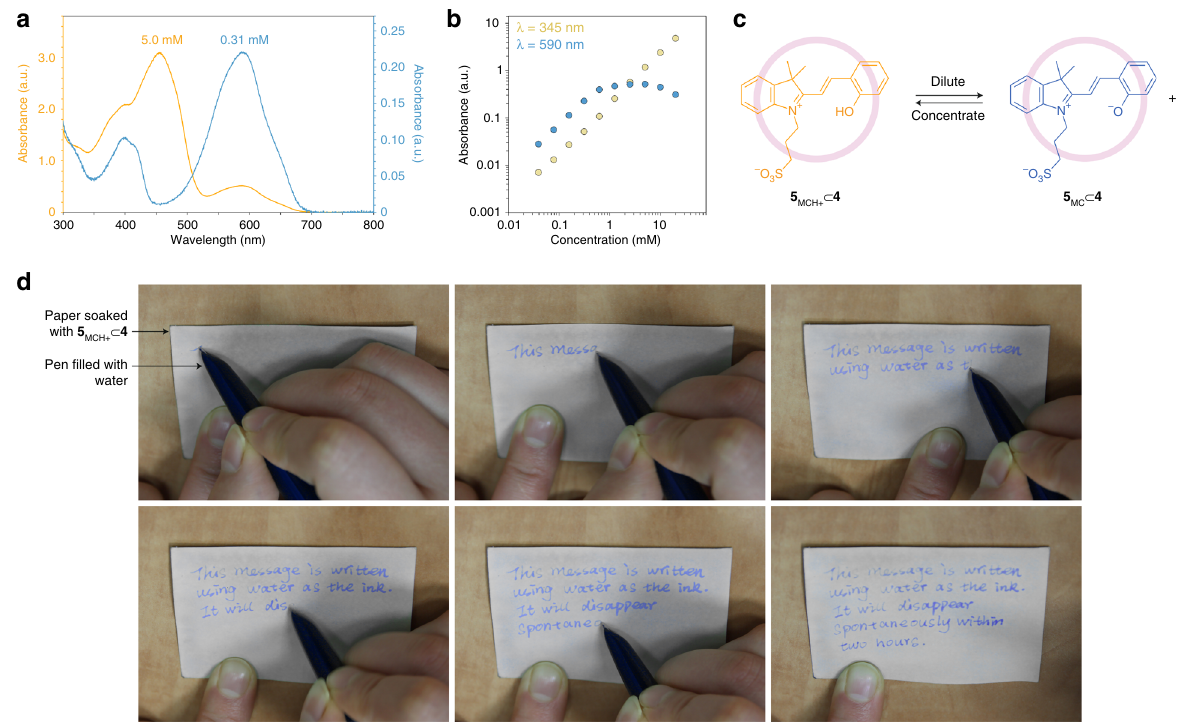
Fig. 3 Concentration-dependent optical properties of encapsulated spiropyran. a UV/Vis absorption spectra of a concentrated (yellow; 5.0 mM) and diluted (blue; 0.31 mM) solution of 5 ⊂ 4 in water. b Concentration dependence of the absorbance of 5 ⊂ 4 at 345 nm (where all isomers of 5 absorb equally) and at 592 nm (where only the MC isomer absorbs). c Dilution-induced deprotonation of the MCH + isomer of 5 encapsulated within 4 . d Writing in a 5 ⊂ 4 - soaked paper with a pen fi lled with pure water. Local delivery of water induces the deprotonation of 4 -encapsulated MCH + and consequently the appearance of a deep-blue color. The created message gradually disappears as water dilute (i.e., blue) aqueous solution of 5 MC ⊂ 4 and then allowed water to evaporate, resulting in an off-white paper (Fig. 3d, top left). We then fi lled the ink reservoir of a fountain pen with pure water, and used it to write on the 5 MCH+ ⊂ 4 -doped paper, as shown in Fig. 3d. The resulting text disappeared spontaneously within ca. 2 h owing to water evaporation, and the process could be repeated. This system has two attractive features: fi rst, the “ ink ” is permanently stored in the paper and it does not need to be delivered from the pen; second, the paper can be used for many write – erase cycles.